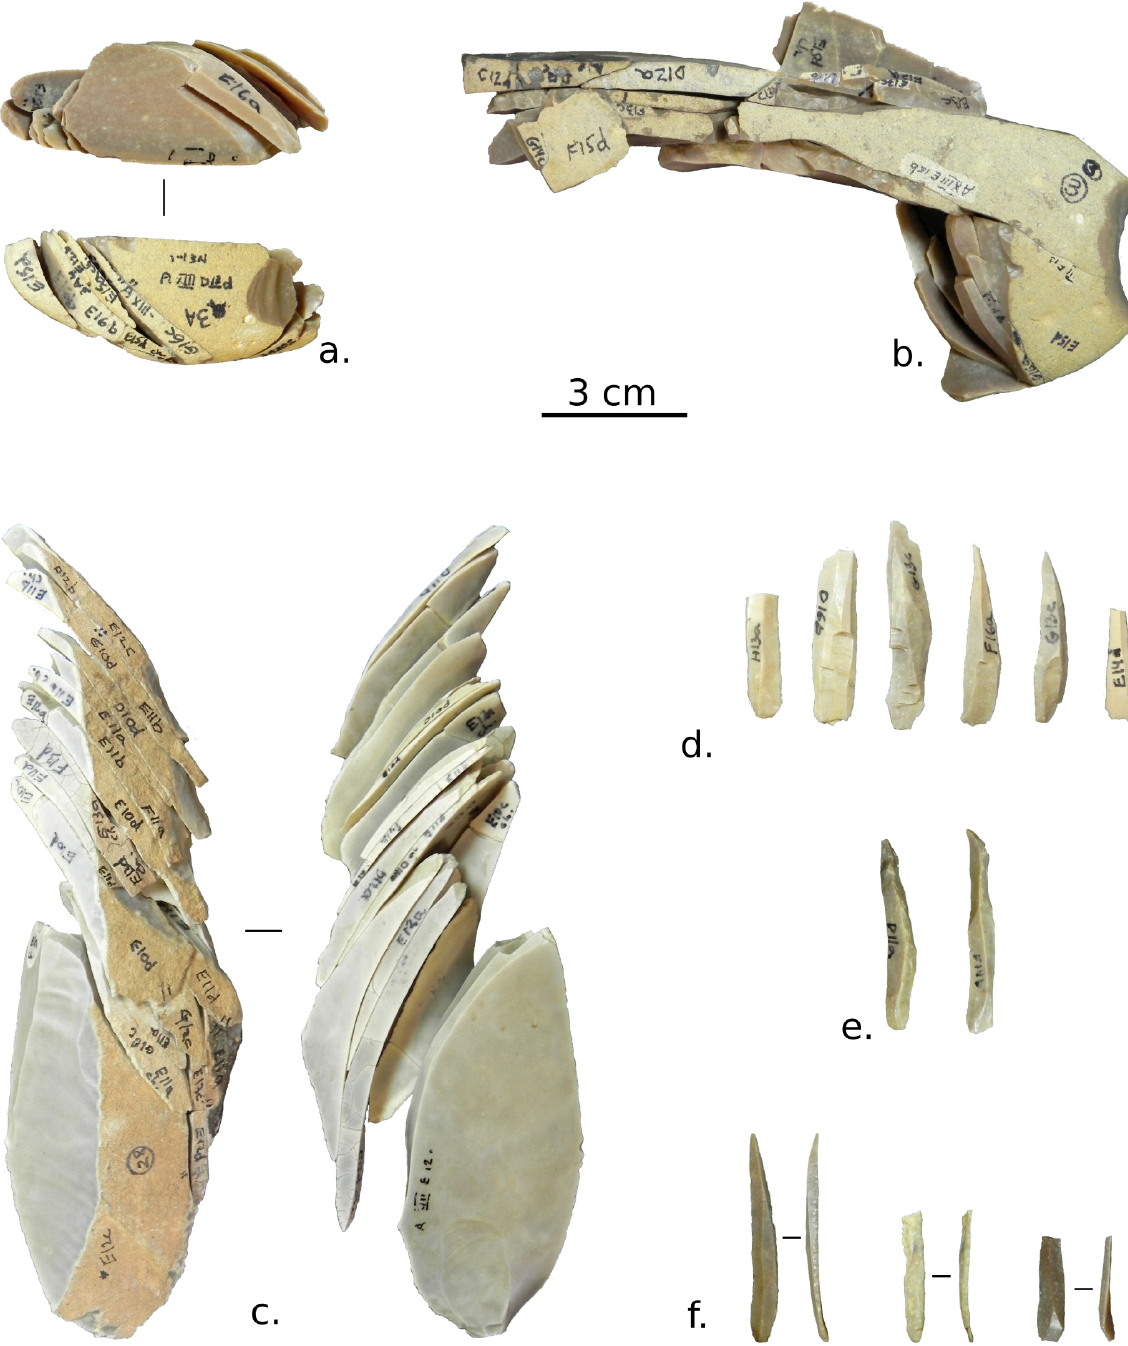
Figure 2. Azariq XIII - lithic artefacts. (a-c) refits – a refits with b, bladelet cores, (d) elongated blanks, (e) crested blades, (f) Ouchtata retouched